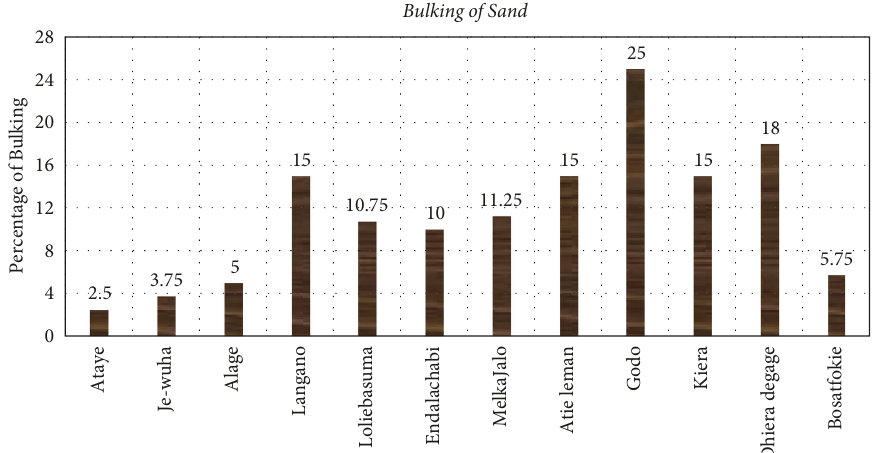
Figure 7: Bulking of sand (source: test results conducted during this study).